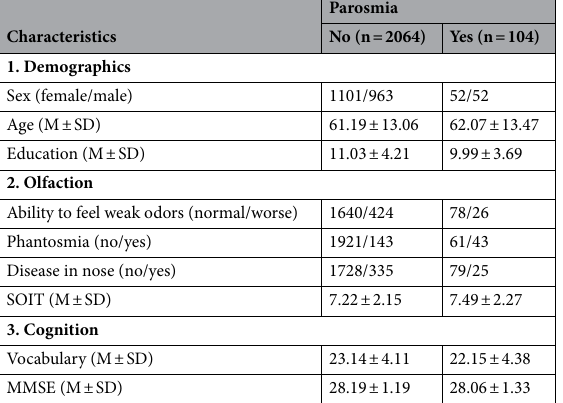
Table 1. Demographic and behavioral characteristics at baseline. M mean, SD standard deviation, MMSE mini-mental state examination, SOIT Scandinavian odor-identification test.